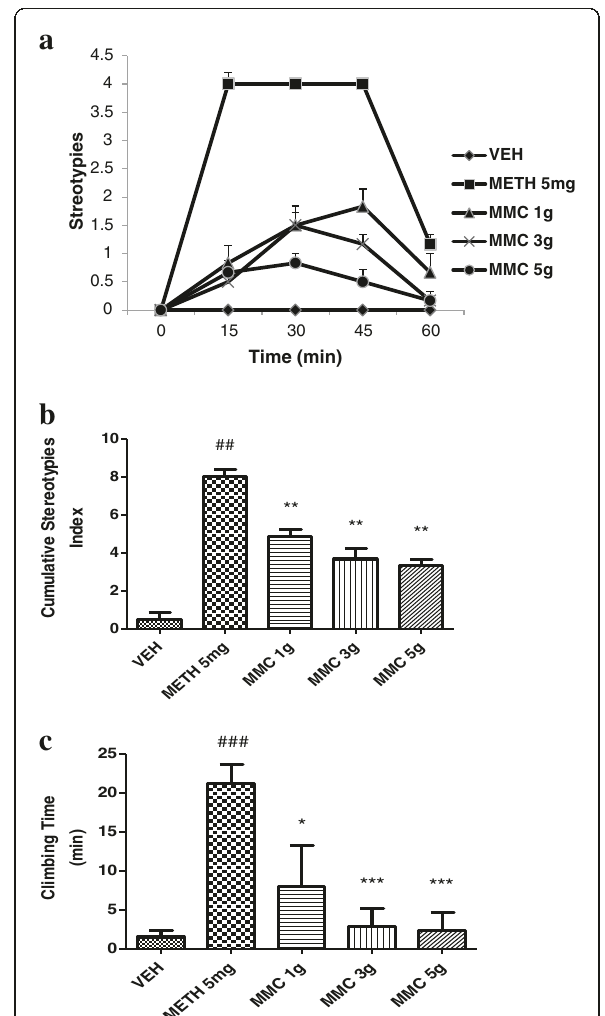
Figure 4 Effect of MMC, (g/kg, p.o) on stereotypies and climbing time induced by methamphetamine in mice. ( a ) Each point represents the mean ± SEM from the stereotypy scores obtained from six animals. ( b ) The cumulative stereotypy scores were measured during 30 to 60 min after administration of methamphetamine. ( c ) Total time spent on the wall of the cage. ### p < 0.001, ## p < 0.01 compared with that of the saline group; * p< 0.05, ** p < 0.01, *** p <0.001 compared with that of the methamphetamine (METH, mg/kg, i.p) group. Haloperidol (2 mg/kg, i.p) showed 100% inhibition on methamphetamine-induced stereotypies in mice (data not shown). n.s- not